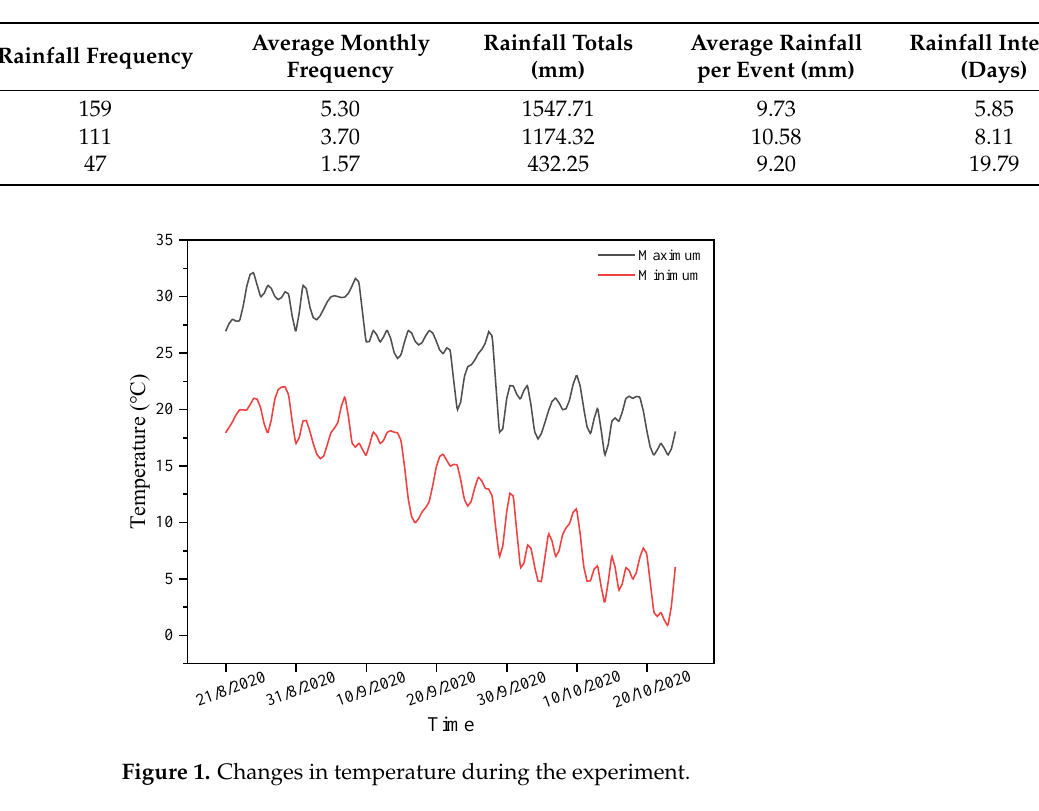
Table 2. Annual rainfall statistics in August, September, and October.